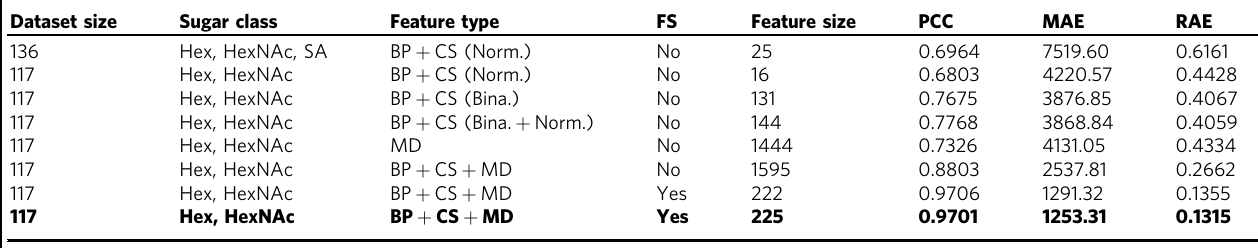
The optimized performance is shown in bold FS Feature selection; BP basic properties; CS (calculated) chemical shifts; MD molecular descriptors; Norm. normalized real values; Bina. binarization